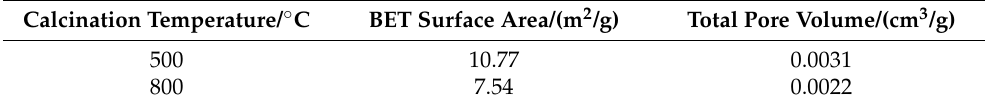
Table 5. Specific surface area of the CG sample formed in the calcination process at different temperatures. Calcination Temperature/ ◦ C